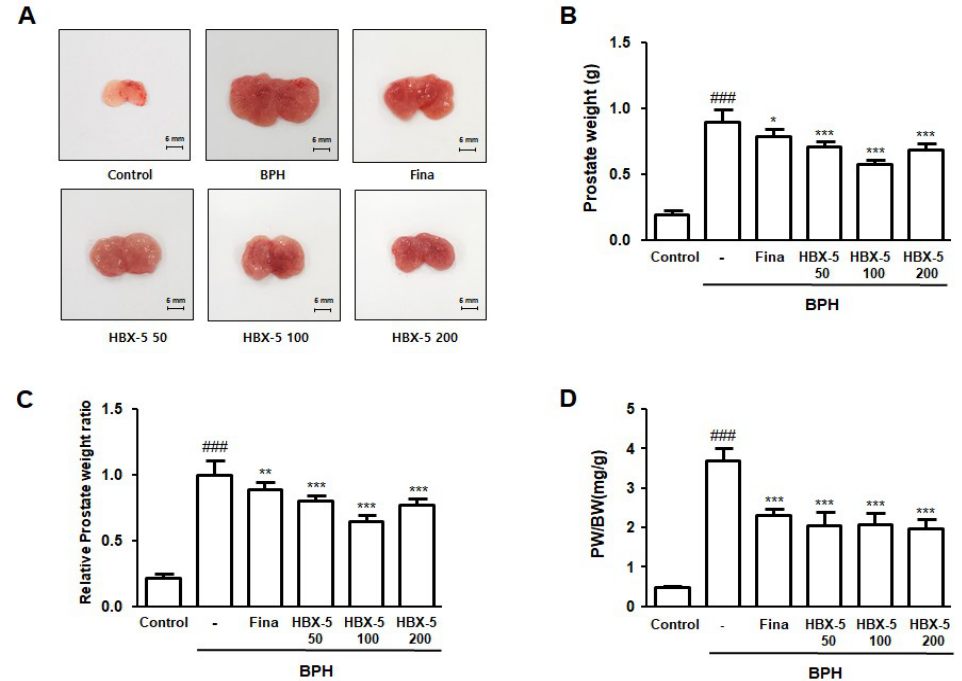
Figure 3. Effect of HBX-5 on prostate weight and prostate index in rat with BPH models. ( A ) A representative photograph of prostate in each group is provided. Change in ( B ) total prostate weight of the rat, ( C ) relative prostate weight ratio and ( D ) PW/BW ratio was assessed for the Control, rat with BPH, Fina and HBX-5 groups. Values are the mean ± SD ( n = 10); ### p < 0.001 vs. control group; * p < 0.05, ** p <0.01, *** p < 0.001 vs. the rat with BPH group; significances between treated groups were determined using ANOVA and Dunnett’s post hoc test.Control, Control group; BPH, rats with BPH group; Fina, rats with BPH group treated with 5 mg/kg/day of finasteride; HBX-5 50, rats with BPH group treated with 50 mg/kg/day of HBX-5; HBX-5 100, rats with BPH group treated with 100 mg/kg/day of HBX-5; HBX-5 200, rats with BPH group treated with 200 mg/kg/day of HBX-5.